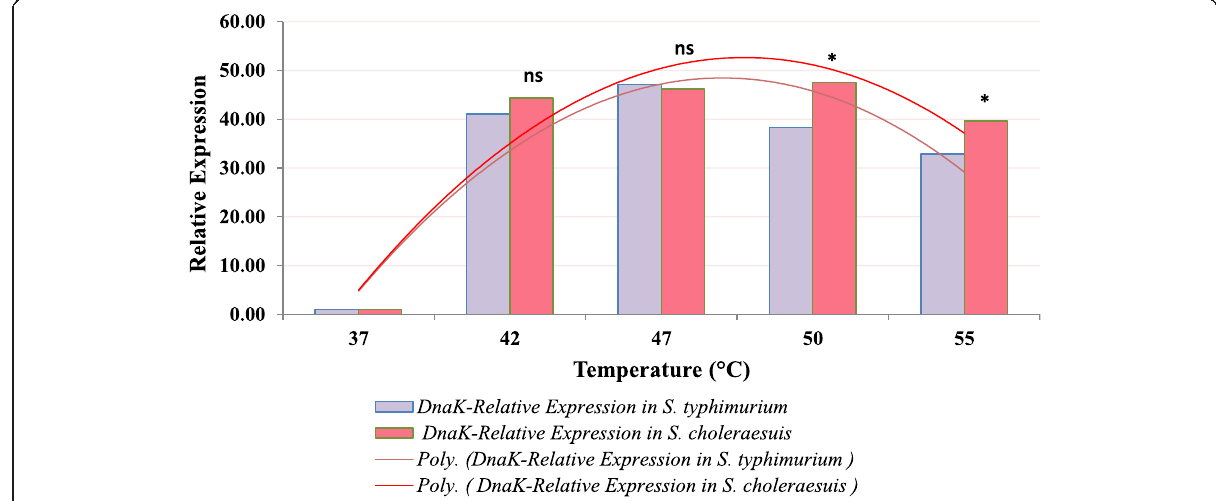
Fig. 3 Relative expression of DnaK gene in S. typhimurium and S. choleraesuis grown under different temperatures. *Significant difference between both bacteria at temperature. ns, no significant difference; Poly., polynomial curve